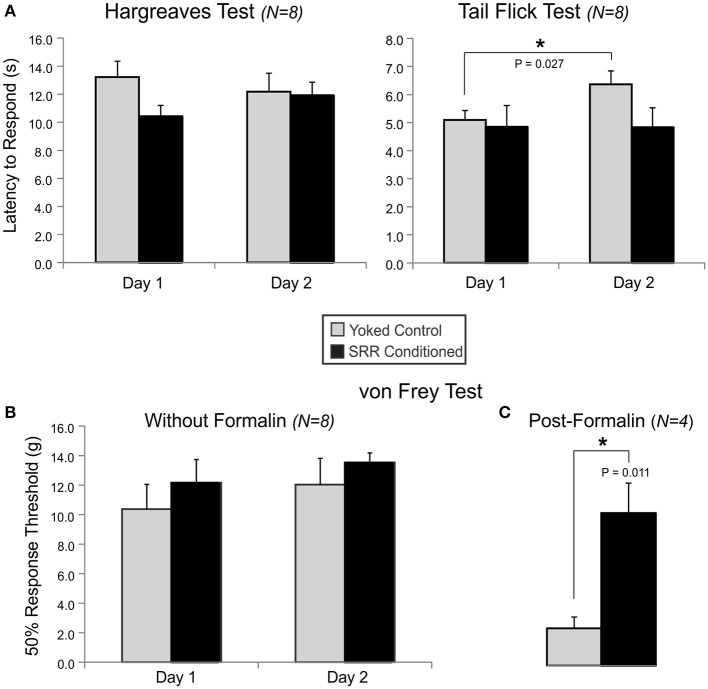
SRR conditioning prevented expression of mechanical allodynia following formalin injection. Shown are results for tests of thermal nociception in an open chamber (Hargreaves) or under restraint (Tail Flick), and mechanical nociception in an open chamber (von Frey) with or without prior formalin injection into the rat's right dorsal hindpaw. (A) There were no group differences in thermal sensitivity at baseline, despite SRR conditioned rats showing a trend toward increased responsiveness to the Hargreaves Test on Day 1 [10.4 ± 0.8 s vs. Yoked: 13.2 ± 1.1 s; t(14) = −2.02, p = 0.064; power (α = 0.05) = 0.47] and Tail Flick Test on Day 2 [4.8 ± 0.7 s vs. Yoked: 6.4 ± 0.5 s; t(14) = −1.81, p = 0.093; power (α = 0.05) = 0.39]. Yoked rats took more time to respond on Day 2 than Day 1 of the Tail Flick Test (*p < 0.05, paired t-test). (B) Results from Days 1 and 2 on the mechanical von Frey Test did not clearly differentiate the two groups of rats. (C) Mechanical nociceptive responses to formalin injection were reduced in SRR conditioned vs. yoked rats on Day 4 of testing (*p < 0.05, Student's t-test).